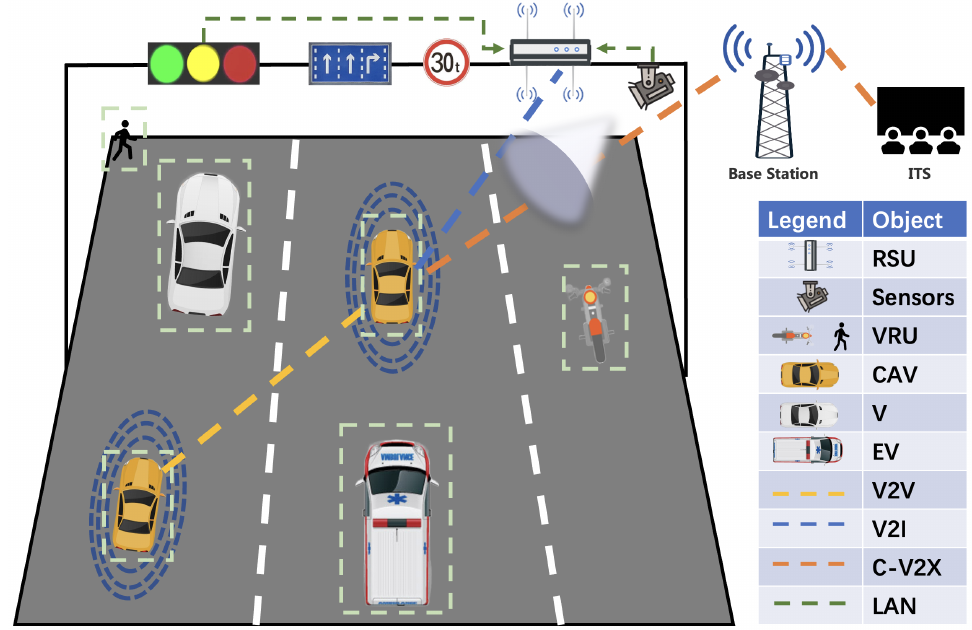
Figure 1. How connected and automated vehicle works and other traffic